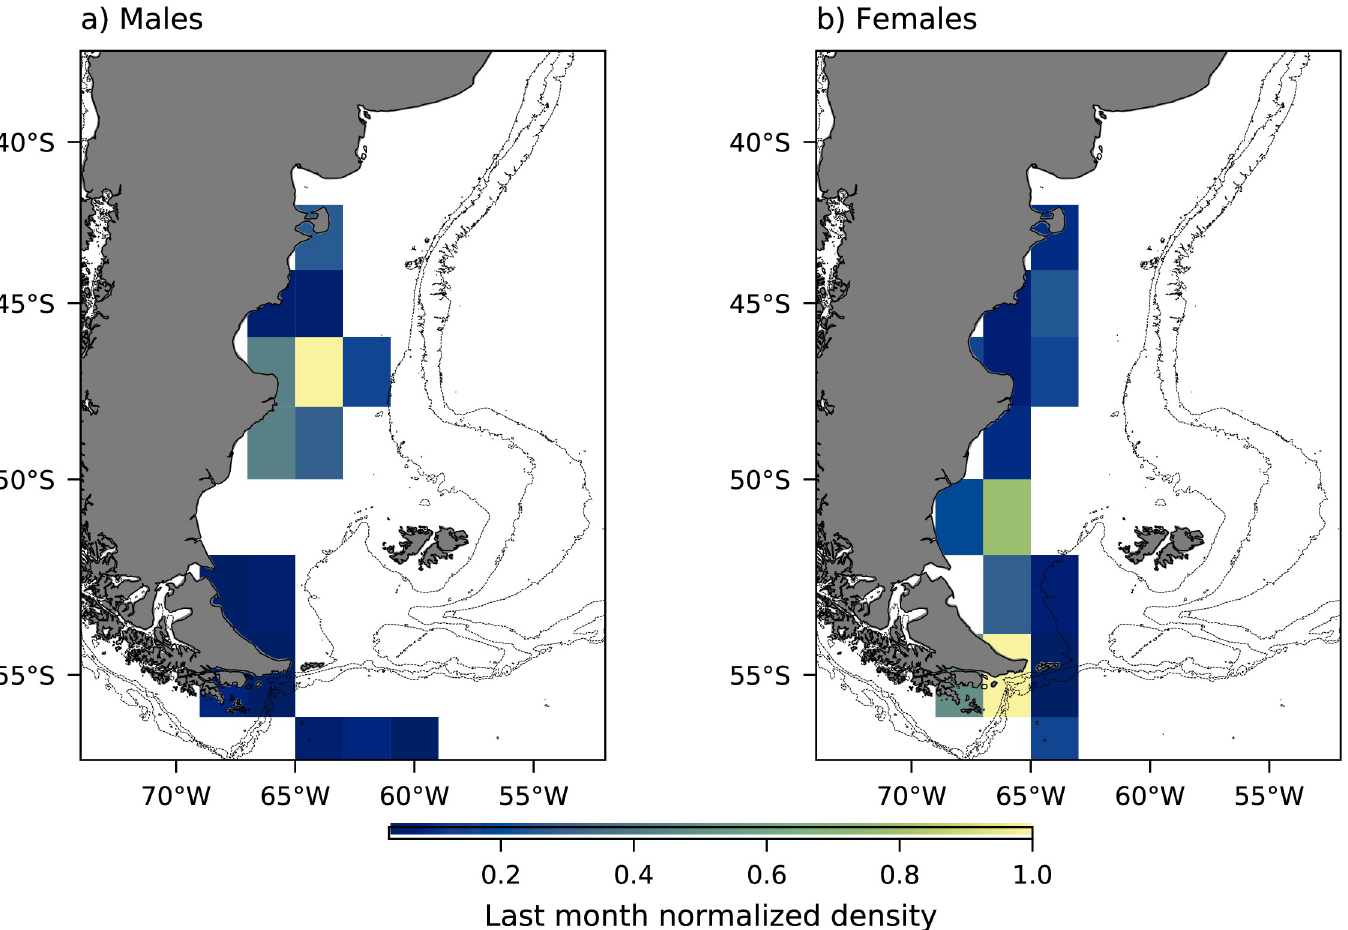
Fig 2. Density plot of female and male Magellanic penguins from Martillo Island during the last month of their winter dispersal (end August- beginning September 2017, grid square: 2˚ latitude x 2˚ longitude). Light gray isobaths were obtained from [55, 56].